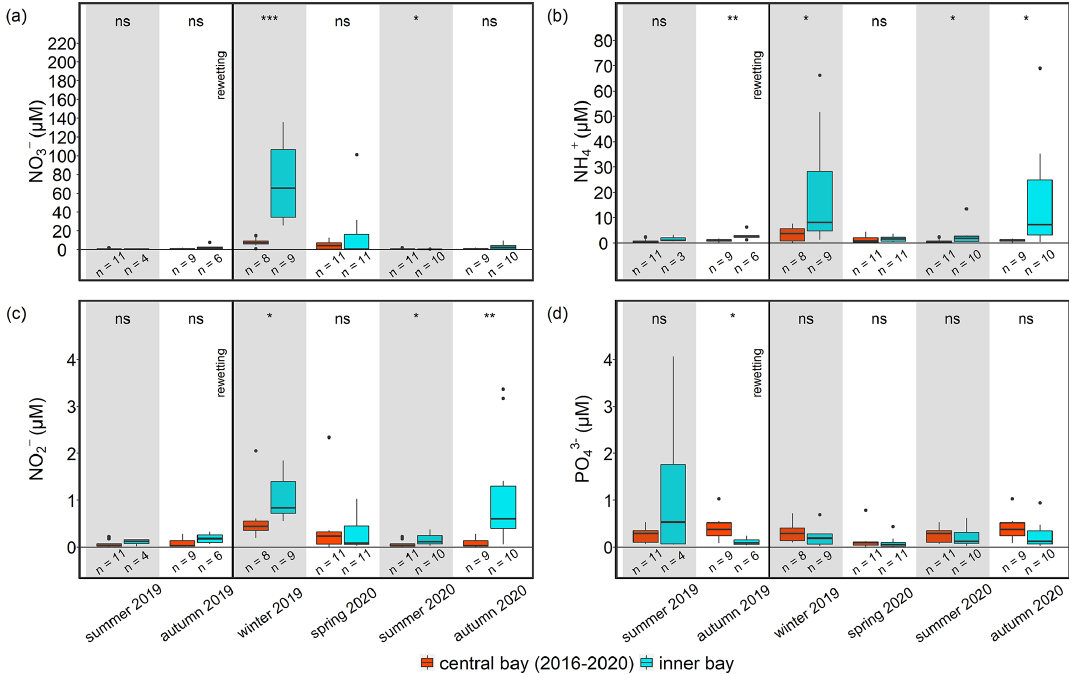
Figure 5. Seasonal nutrient concentrations of (a) NO − red) and in the inner bay (inner bay, blue) from pre- to post-rewetting. The vertical black line indicates the rewetting event. Note that 5-year data (2016–2020) are shown for the central bay (see Sect. 2.4.2). ns is for not significant, and the asterisks denote the following: ∗ p < 0 . 05, ∗∗ p < 0 . 01, and ∗∗∗ p < 0 . 001.